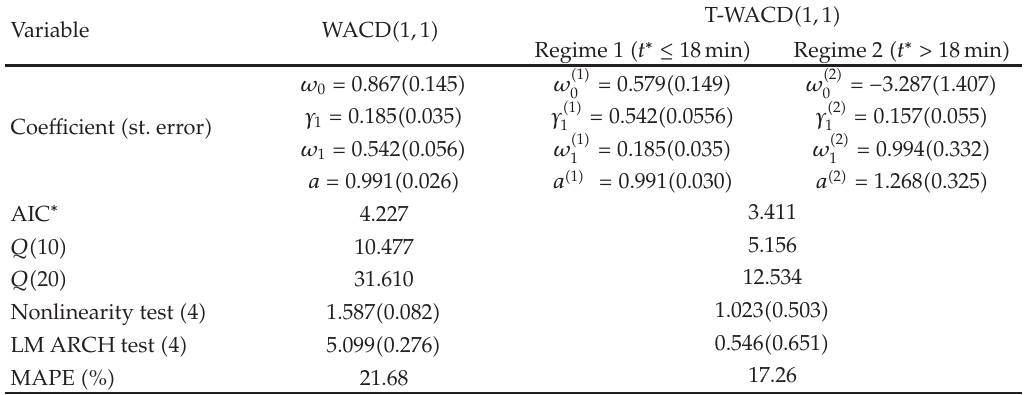
Table 3: Estimation results for WACD (cid:3) 1 , 1 (cid:4) and T-WACD (cid:3) 1 , 1 (cid:4) models for the observed congestion